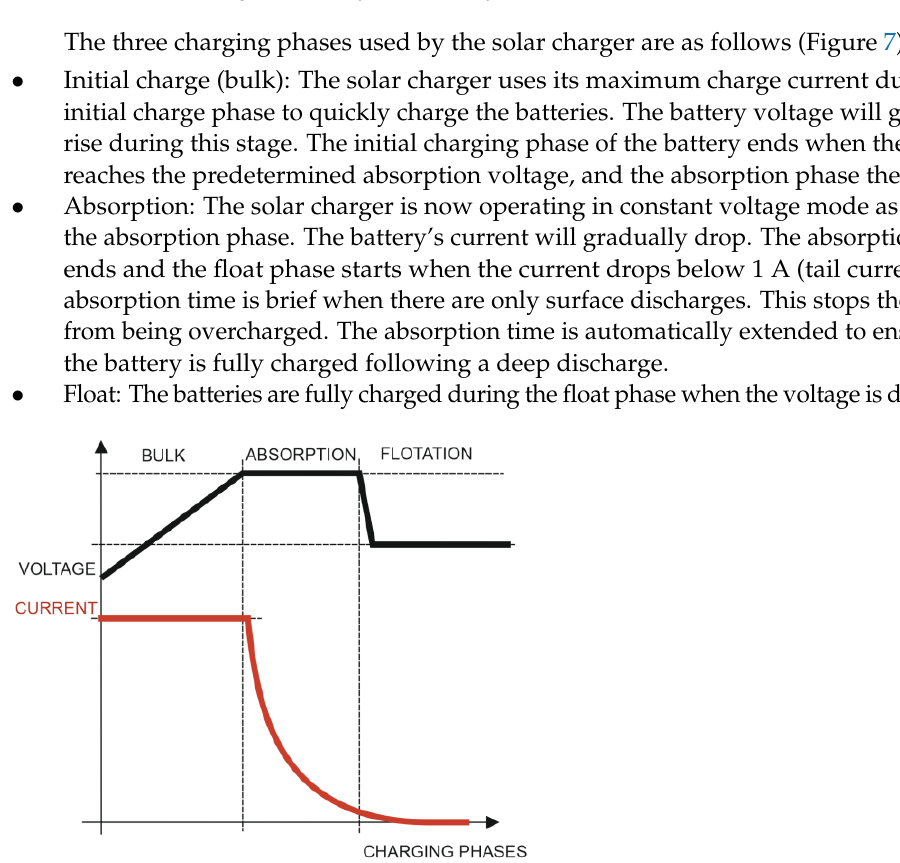
Figure 6. Photovoltaic generation system: 4-relay modules of on/off actuator.